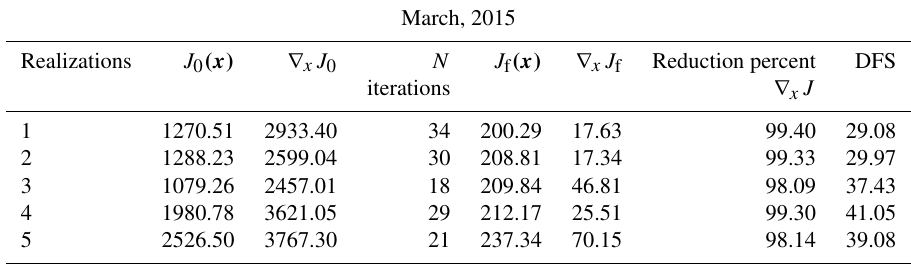
Table C2. Convergence diagnostic of sensitivity case (2) after the inversion using an ensemble of five independent OSSEs for March 2015 ( ∇ x J 0 and ∇ x J 0 represent the initial cost function and its gradient at the beginning of the optimization, and ∇ x J f and ∇ x J f represent them at the end of the optimization).